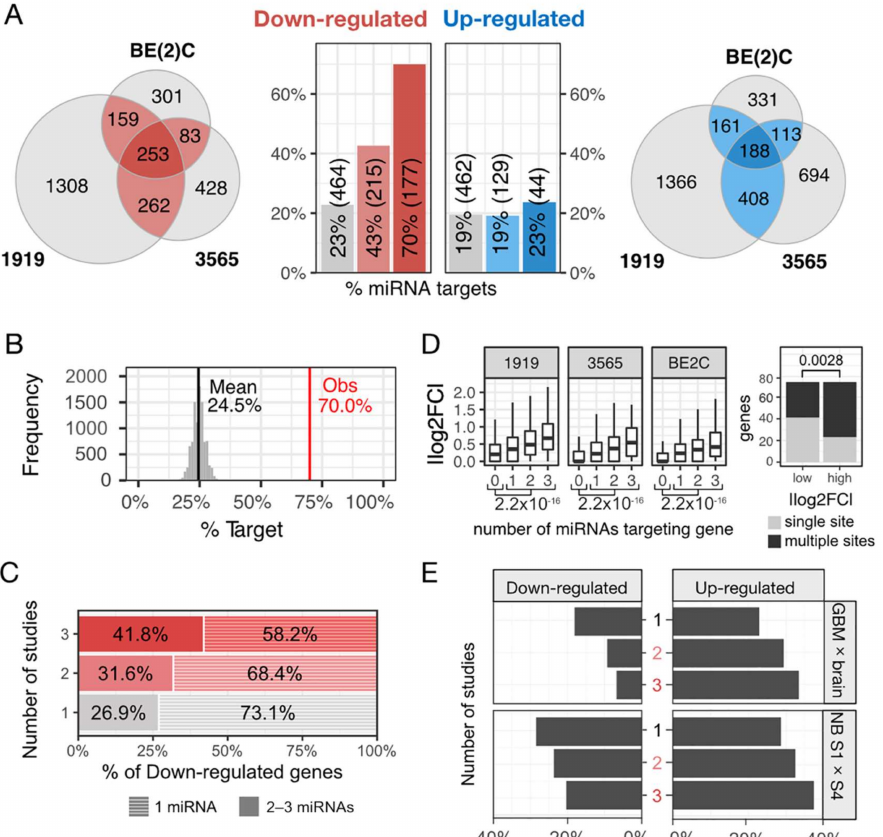
Figure 5. RNA-seq analysis of cells transfected with control and miRNA combo mimics. ( A ) Overlap between results of RNA-seq studies done in BE(2)C, GSCs 1919, and 3565 transfected with control vs. miRNA combination (miR-124, -128, and -137) mimics. Bar graphs: percentage of genes targeted by at least one of the transfected miRNAs identified in one, two, or all studies. Considering Venn- diagrams of down- and upregulated genes. As expected, we found an over-representation (253) in the downregulated genes ( p -value = 0.000000602; 1.24-fold enrichment; Hypergeometric test) and an under-representation (188) of upregulated genes ( p -value = 0.0000006; Hypergeometric test) shared by the three cell lines. ( B ) Number of genes targeted by at least one of the three transfected miRNAs appearing in the overlap of the three studies is much higher than expected by chance ( p -value = 6.83 × 10 − 66 ). ( C ) Percentage of genes targeted by two or three of the transfected miRNAs appearing in the overlap of the three studies is much higher than the number observed in single studies. ( D ) Left: Genes targeted by all three miRNAs show greater decrease in expression versus genes targeted by two or a single miRNA. Right: Genes with multiple miRNA binding sites displayed higher silencing level in comparison to genes with a single miRNA binding site. ( E ) Percentage of miRNA target genes in all three, two, or single studies with increased expression in GBM in relation to normal brain (cortex) and stage 4 neuroblastoma compared to stage